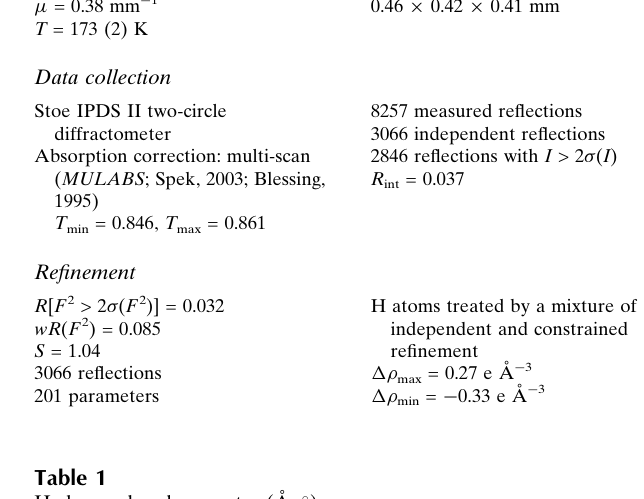
Hydrogen-bond geometry (A˚ , (cid:2)